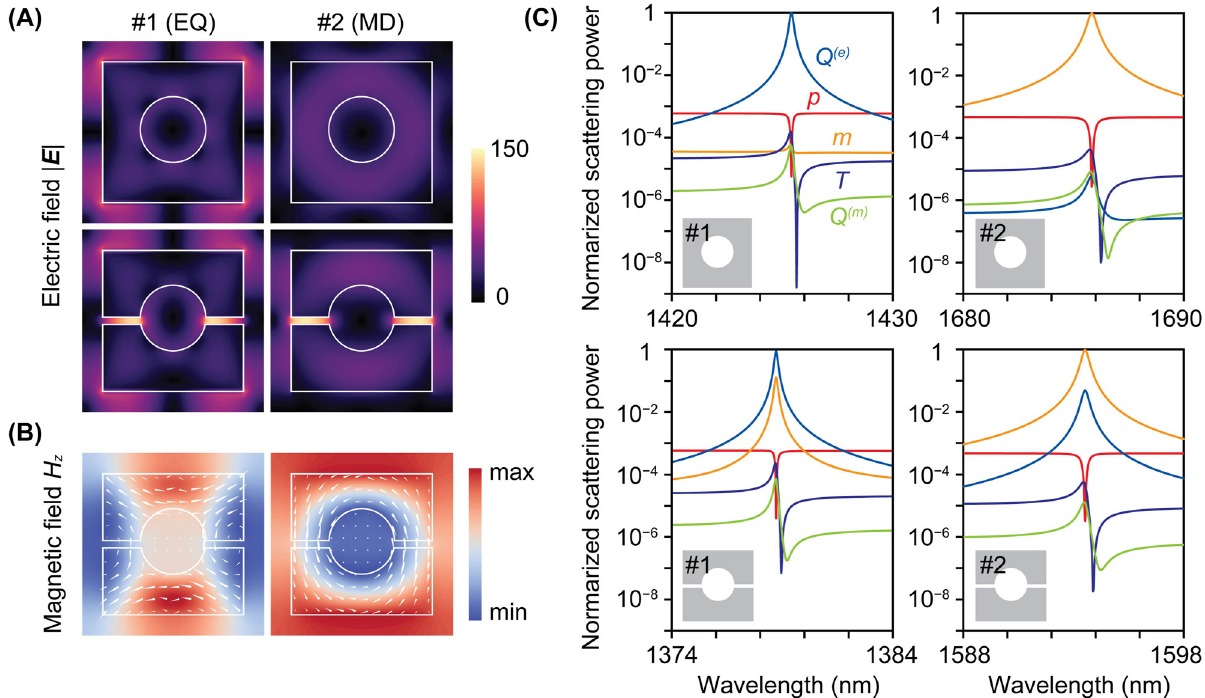
Figure 2: Field distributions and the origin of the two quasi-BIC modes. (A) Simulated electric field | E | profiles for metasurfaces ( s / L = 2%) without nanogaps (upper) and with nanogaps (lower) for mode #1 (left) and #2 (right), respectively. (B) Simulated H nanogaps. White arrows show the displacement current. (C) Multipole contributions in scattering powers obtained by the multipole decomposition in each resonance mode. The scattering powers are normalized to the sum of the components of all the multipoles. p : electric dipole; T : toroidal dipole; m : magnetic dipole; Q ( e ) : electric quadrupole; Q ( m ) : magnetic quadrupole.